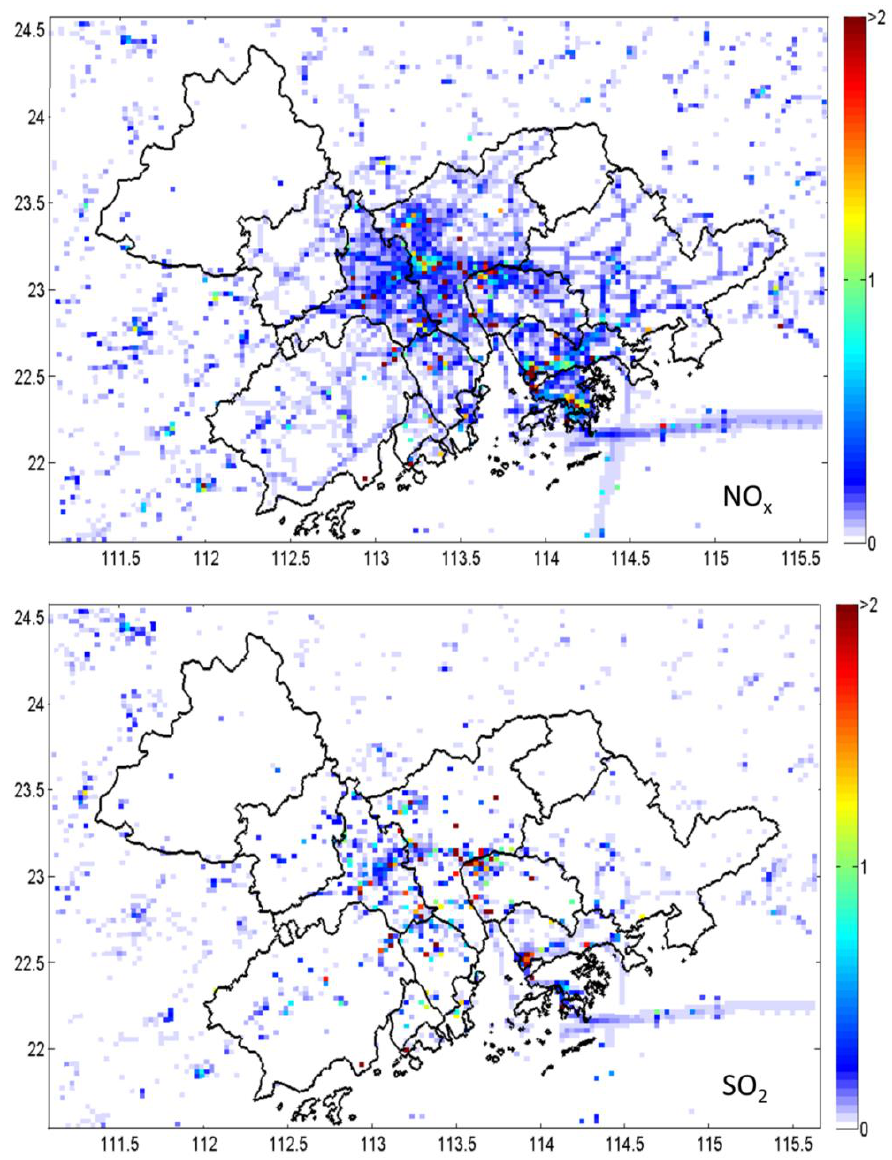
Figure 2. August and February averaged SO 2 and NO x emissions in the Pearl River Delta (PRD) region. Unit: moles/s.